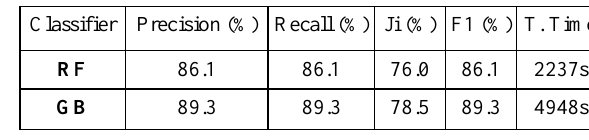
Table 1. Metrics summary for RF and GB classifiers With unbalanced classes (which is our case), it is easy to get high- performance metrics without making useful predictions Figure 9. Complete data set – Label distribution (by thousand) (some code colour as Figure. 1)